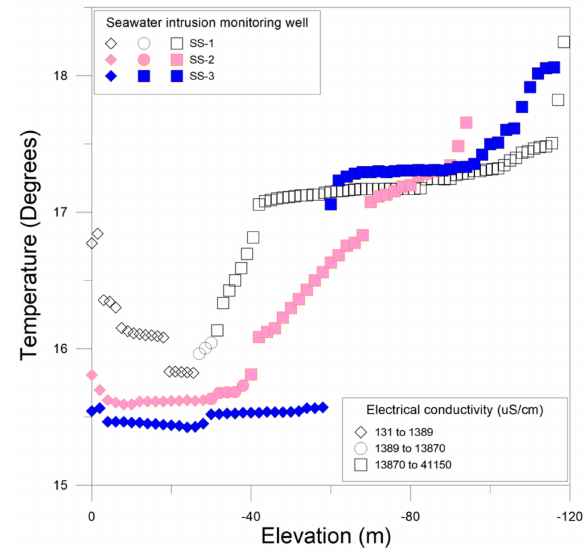
Figure 4. Temperature variations of coastal aquifers in Susan